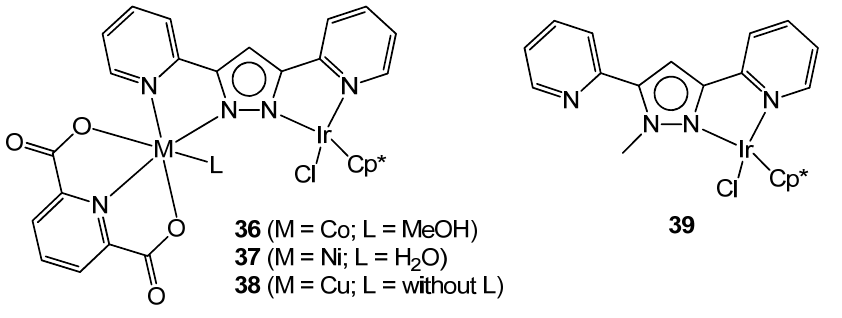
Figure 5. Depiction of complexes 36–39.